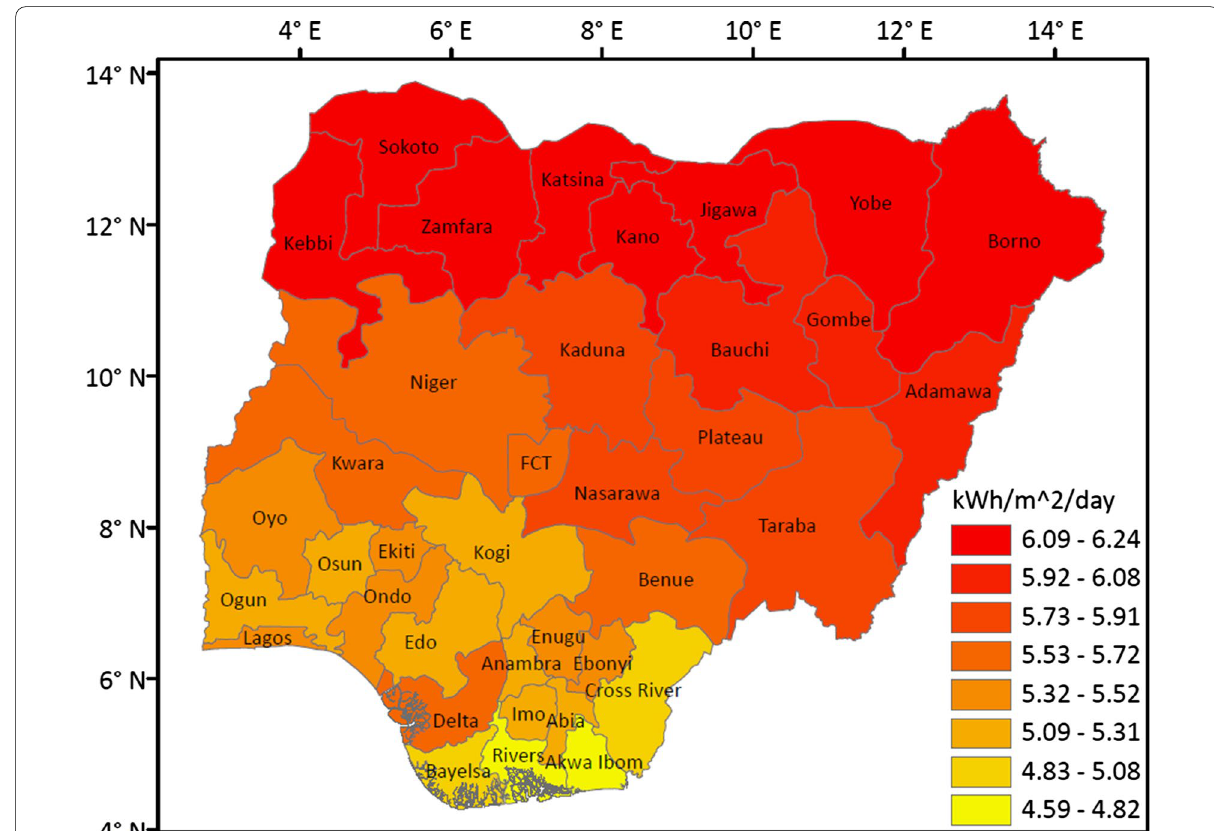
Fig. 1 Map of Nigeria indicating the global solar radiation (Gh) on the optimally inclined plane across the states (Nwokocha et al.